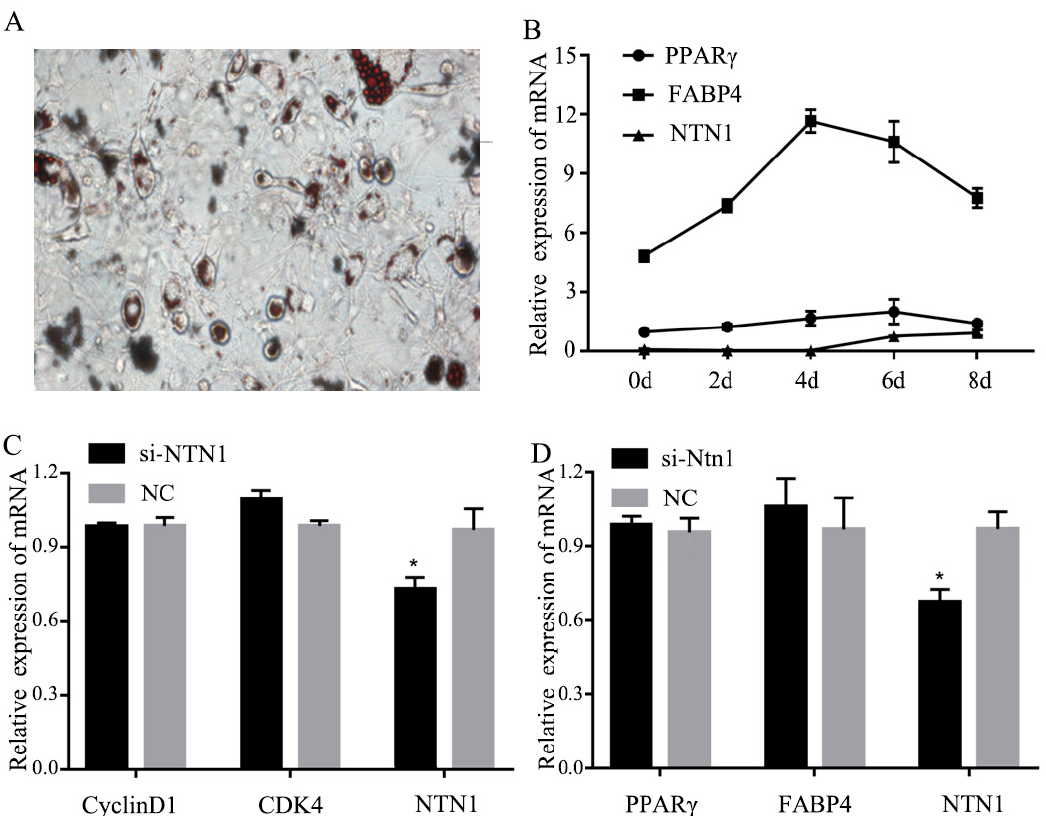
Figure 4. E ff ect of si- NTN1 on the proliferation and di ff erentiation of 3T3-L1 cells. ( A ) Oil red O staining of di ff erentiation 3T3-L1 cells. ( B ) The expression levels of NTN1, Peroxisome proliferator-activated receptor gamma (PPAR γ ) and fatty acid binding protein 4 ( FABP4 ) in 3T3-L1 adipocytes. ( C ) Expression of Cyclin D1 , cyclin dependent kinase 4 ( CDK4 ) and NTN1 gene in 3T3-L1 cell proliferation phase. ( D ) Expression of P PAR γ , FABP4 , and NTN1 gene in 3T3-L1 cell di ff erentiation phase. The results were represented as mean ± SD. The expression level of genes in si- NTN1 3T3-L1 cells was determined by q-PCR using NC as the control. * p < 0.05.